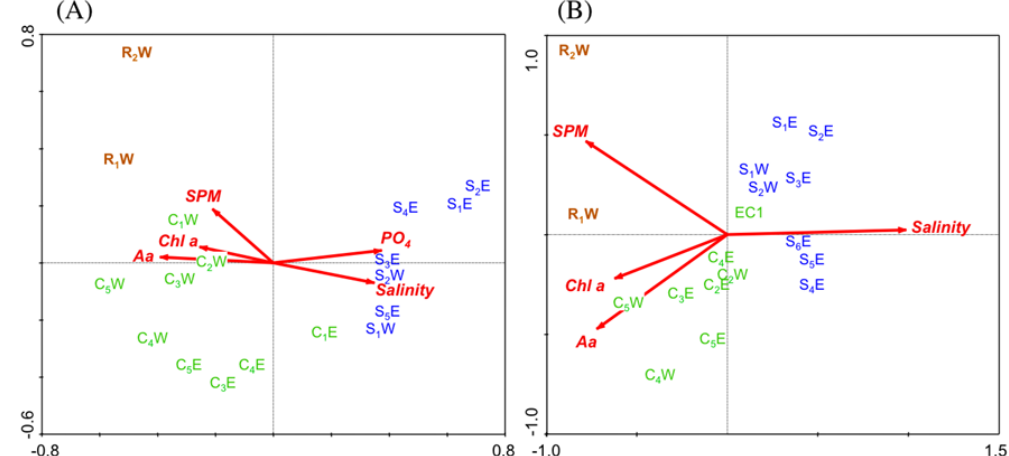
Fig. 3. Canonical correspondence analysis of bacterioplankton community structure from particle-attached (PA, A ) and free-living (FL, B ) samples using environmental variables. The length of the arrow represents degree of correlation with presented axis. SPM: suspended particulate matter. Chl a : chlorophyll a concentration. Aa: amino acid concentration. PO 4 : phosphate concentration. Brown letters: river samples. Green letters: coast samples. Blue letters: open sea samples